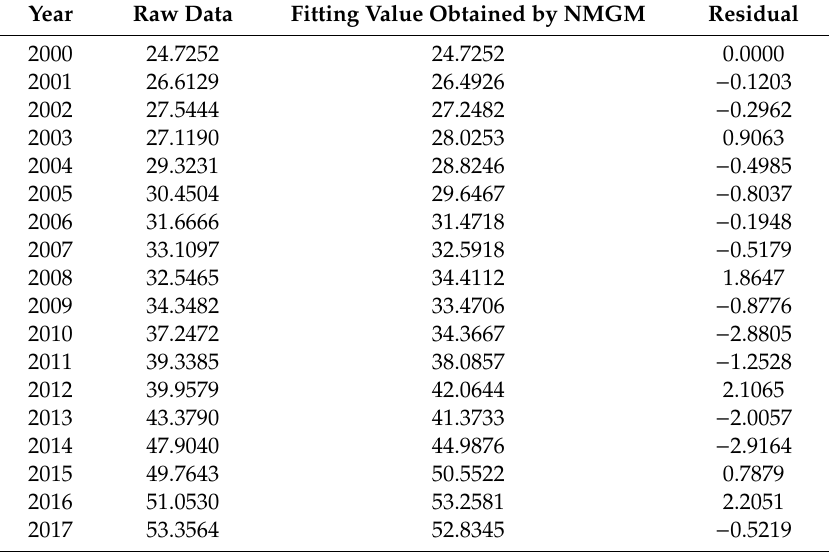
Table 10. Residual based on NMGM model.